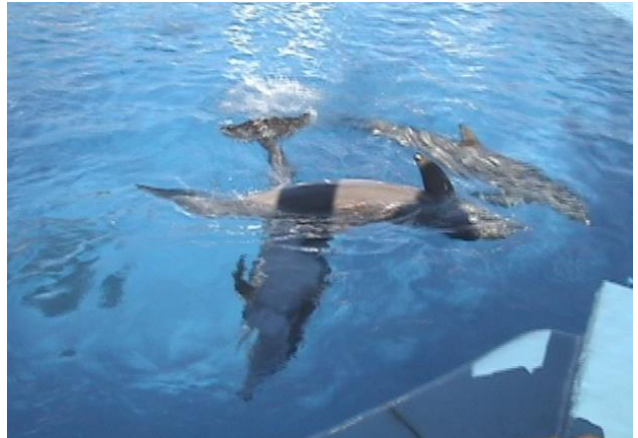
Figure 14 . Copulation (COP) between animal 8 and animal 6.